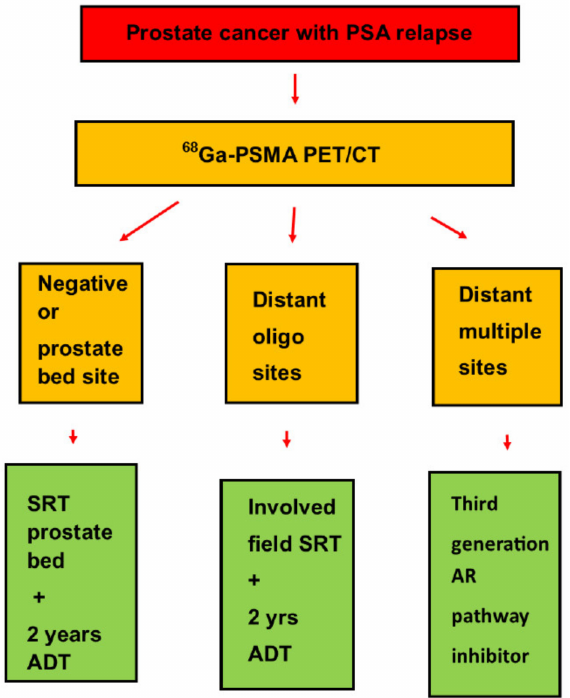
Figure 4. This figure summarizes how 68 Ga-PSMA PET/CT findings may change treatment decisions for the salvage treatment of patients with PSA